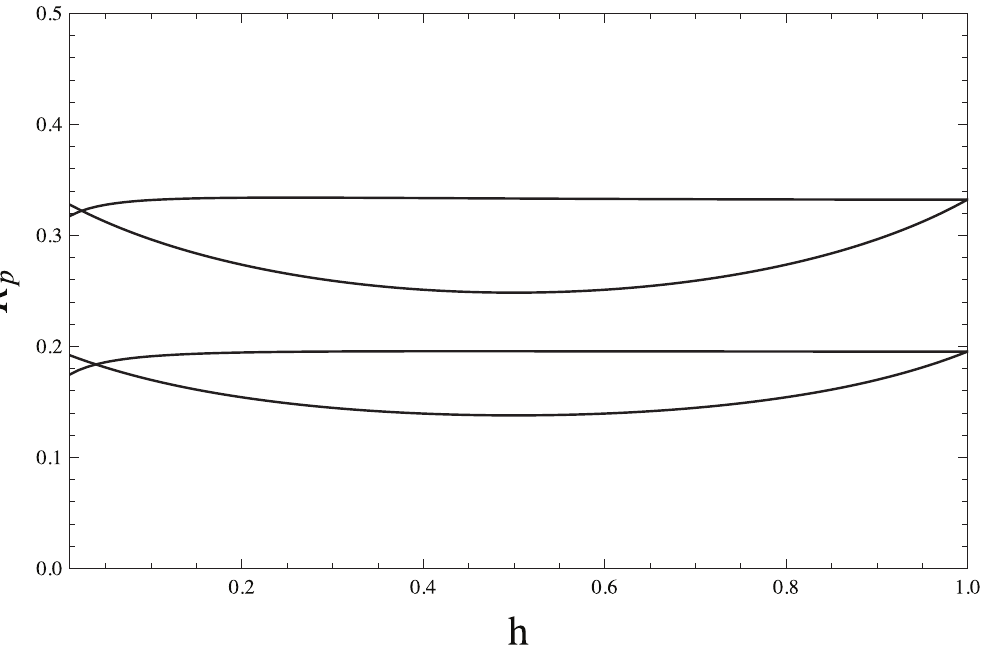
Figure 2. Graph comparing the probability of identity R p in the DGR scenario to that obtained in the VGE scenario. The quasi flat line is the the value of R p for the VGE scenario obtained without making any assumption on the value h can take, while the downward bent line is the relatedness for the DGR scenario. The first set of two lines in the graph is for N ~ 10 , while the second set of two lines is for N ~ 20 , while the other parameter values are m ~ 0 : 1 , w ~ 0 : 5 , v ~ 0 : 5 , and g ( e ) ~ e c , where the value c takes does not affect R p